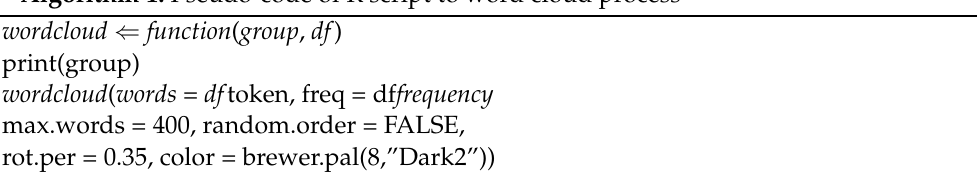
Algorithm 1: Pseudo-code of R script to word cloud process wordcloud ⇐ function ( group , df )